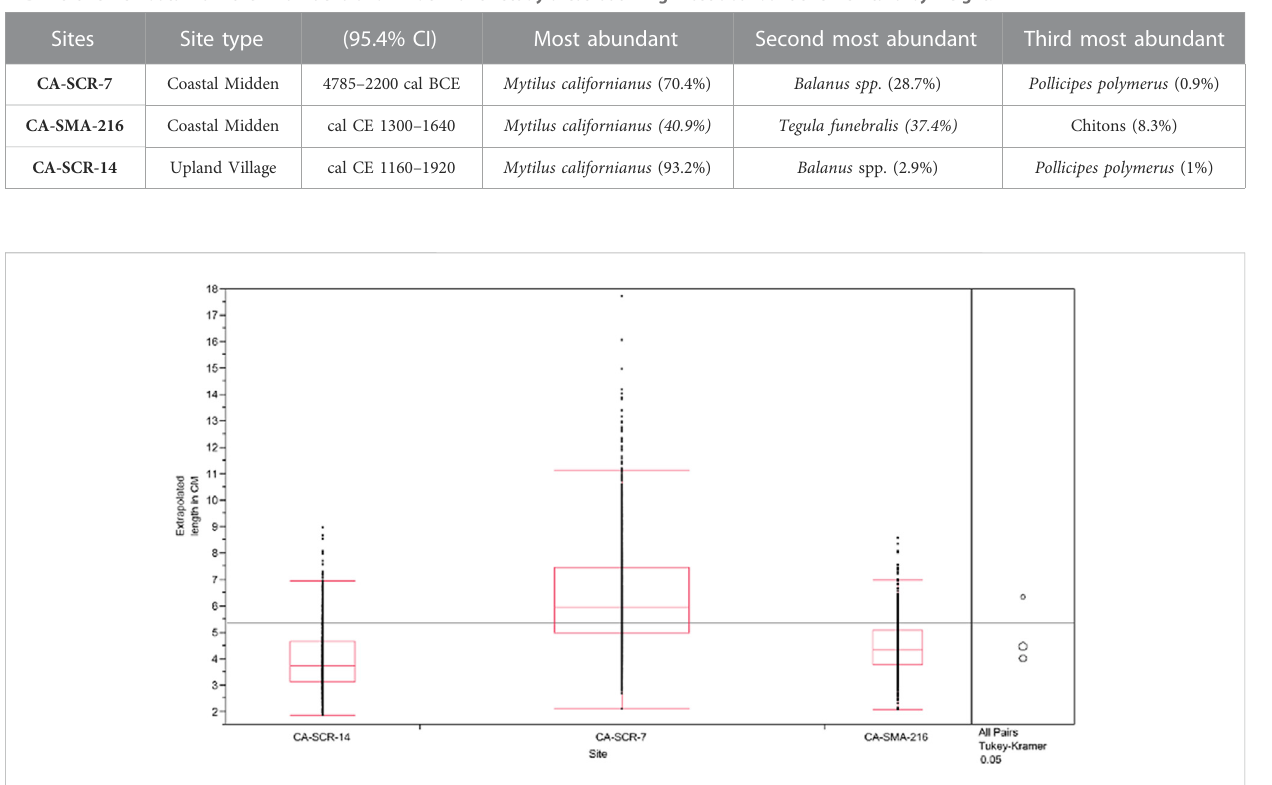
FIGURE 6 Comparison of California mussel umbone data from sites.